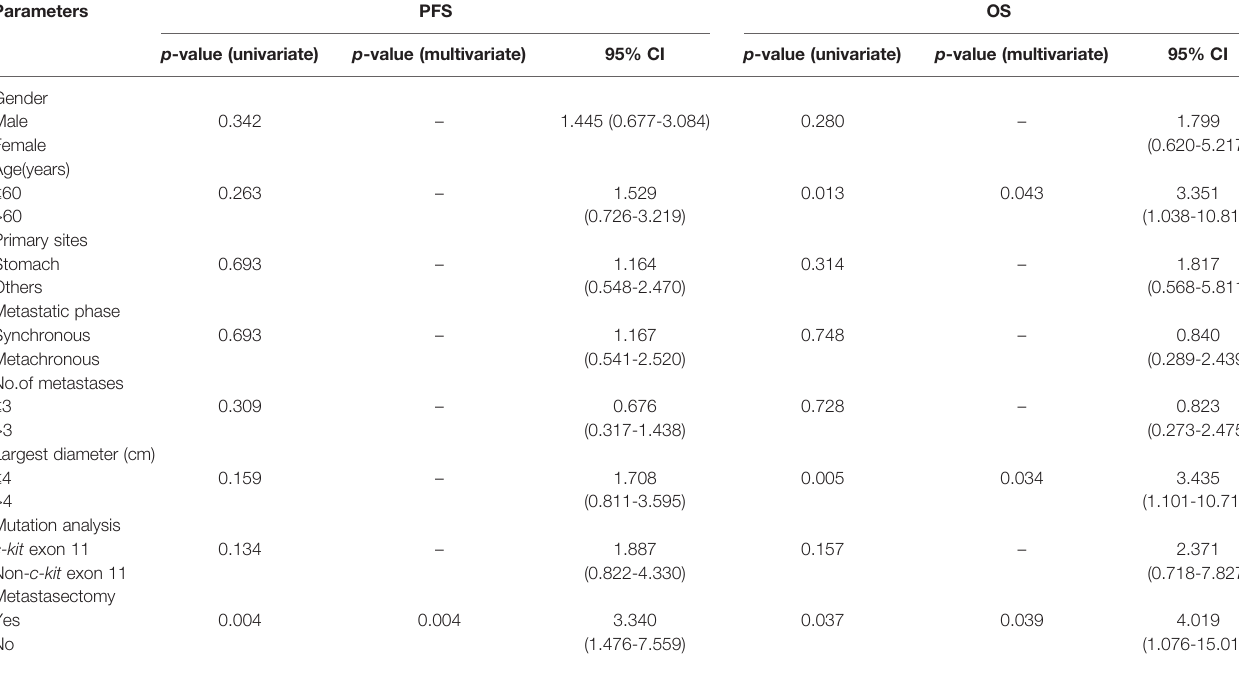
TABLE 4 | Prognostic factors for progression-free survival (PFS) and overall survival (OS) after propensity score matching. Parameters PFS OS p -value (univariate) p -value (multivariate) 95% CI p -value (univariate) p -value (multivariate) 95%